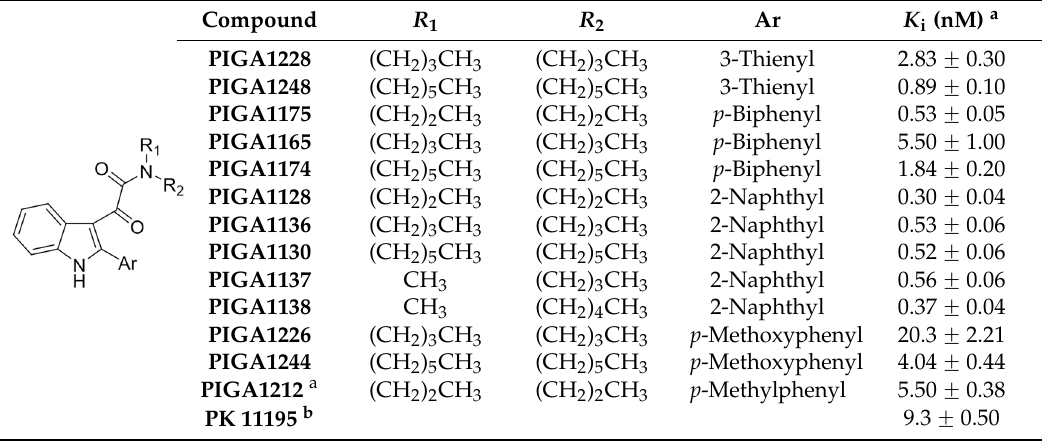
Figure 2. Effects of the PIGA ligands on pregnenolone production. C6 glioma cells ( A ) and U87MG cells ( B ) were incubated with different PIGA ligands (40 µM) for 2 h at 37 °C. The pregnenolone amounts were quantified by a competitive enzyme-linked immunosorbent assay. The data are expressed as percentage of pregnenolone production compared to the control, which was set to 100%, and represent the means ± SEM of three different determinations performed in duplicate. The statistical analysis was performed using one-way ANOVA and Bonferroni’s post-test; * p < 0.05, ** p < 0.01, *** p < 0.001 vs. the